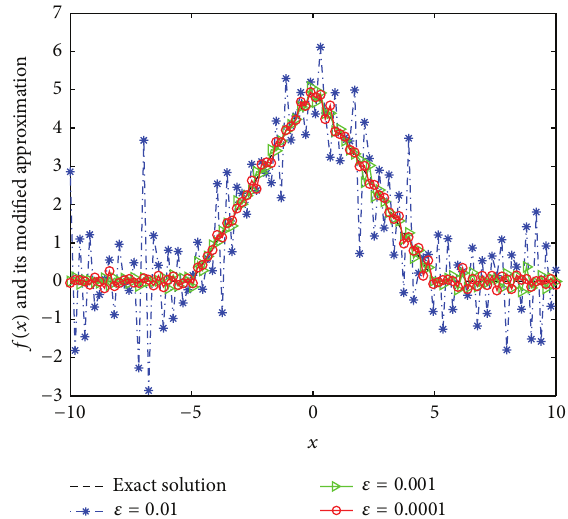
be measured in the sense of Root Mean Square Error